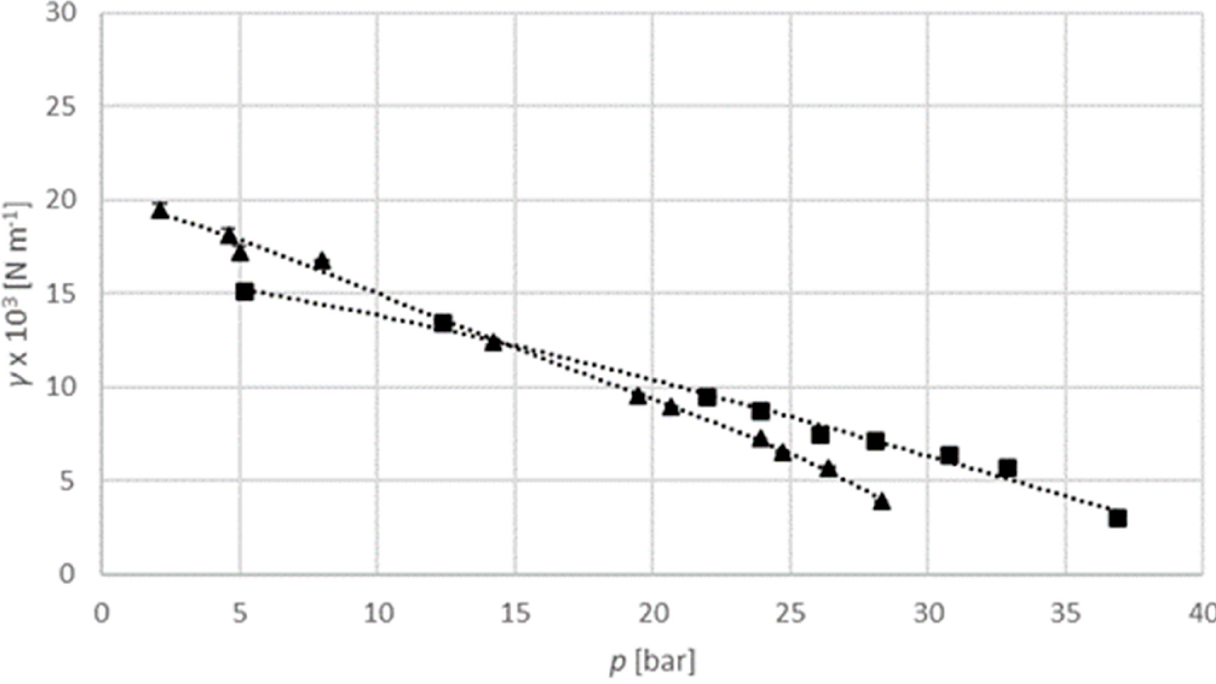
Figure 4. The viscosity of pure gas as a function of pressure in comparison to literature data: , measured data at 313.15 K; , measured data at 333.15 K; X, pure gas at 313.15 K [16]; , pure gas at 333.15 K